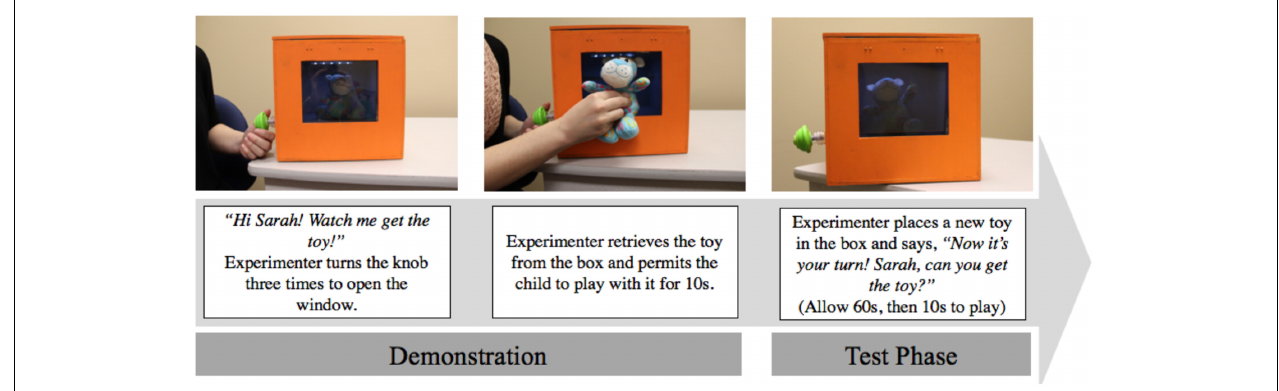
FIGURE 4 | Detour-reaching task: demonstration and test